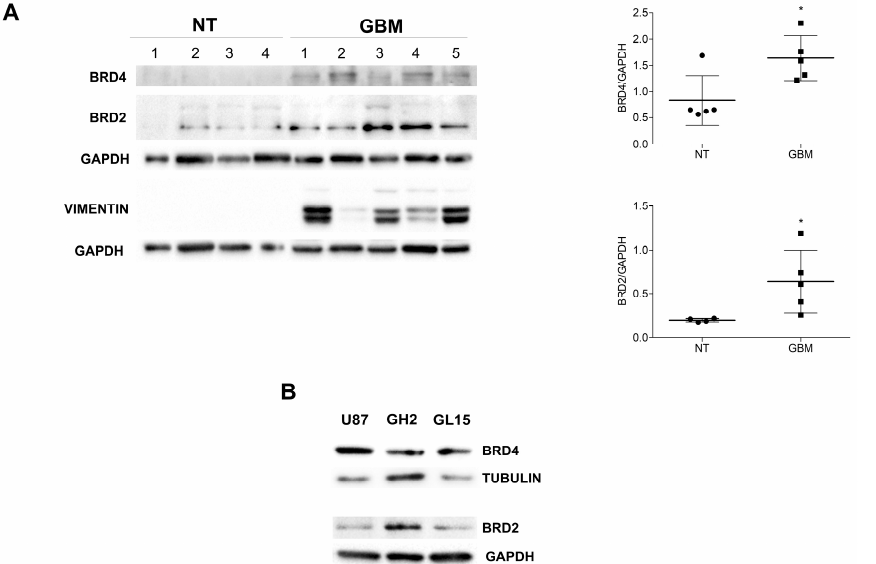
Figure 1. BRD protein expression in GBM tissues and cells. (A) Protein extracts from non-tumoral surgical cerebral tissues (NT) and from GBM specimens (GBM) were subjected to Western blo tt ing analysis for BRD4 and BRD2 proteins by using speci fi c antibodies. VIMENTIN expression was used as a tumorigenicity control and GAPDH as a loading control. Densitometric analyses of BRD4 and BRD2 expression are shown in the graphs. The sum of all the bands of the BRD2 protein was ana- lyzed. Statistical signi fi cance: * p < 0.05, Student t-test and. ( B ) Western bo tt ing analysis of BRD4 and BRD2 was performed on protein extracts from U87, GH2, and GL15 cells, and a representative image is shown.